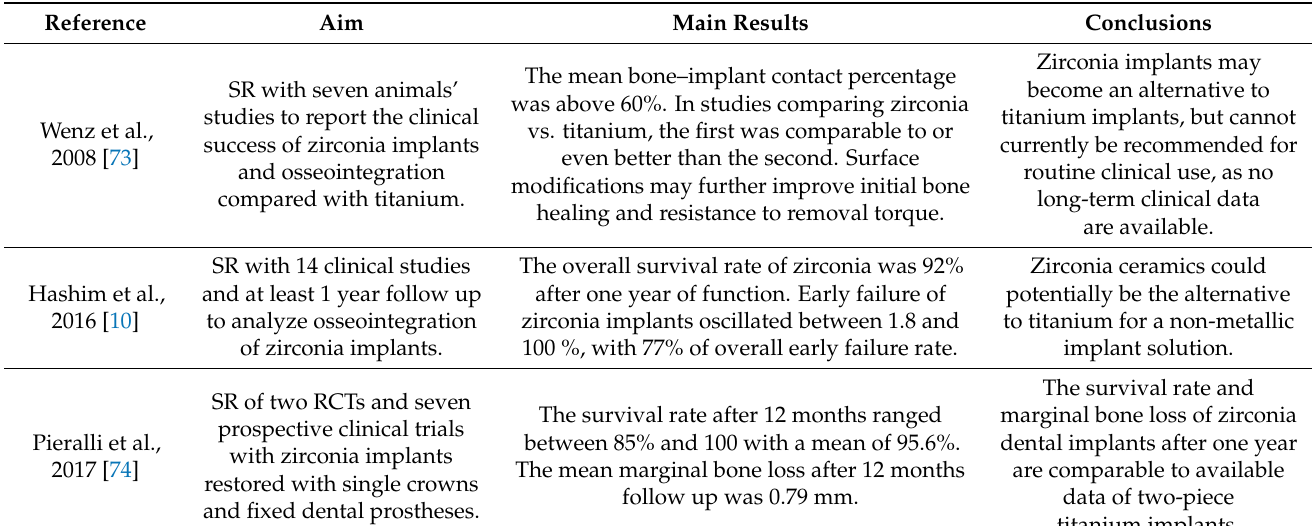
Table 1. Summary of systematic reviews (SRs) analyzing the osseointegration of zirconia